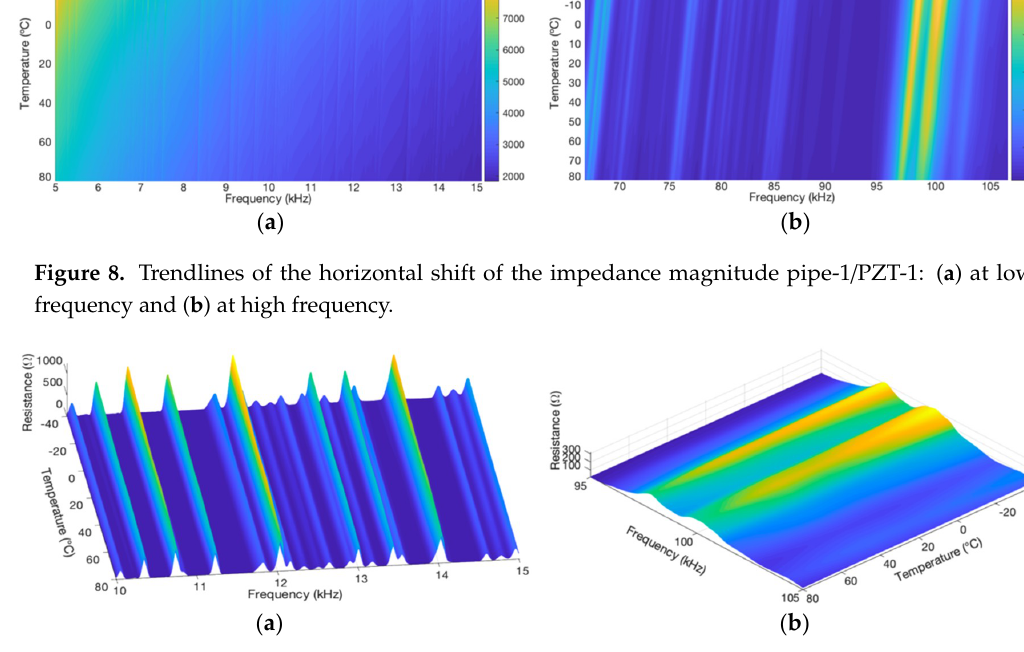
( b ) Figure 10. Damage metrics and the effect of temperature pipe-1/PZT-1: ( a ) RMSD and ( b ) CCDM. In Figure 10, it is observed that the real damage (red bar) presented a RMSD value lower than the values obtained by only changing the temperature, and a CCDM value very close to those obtained due to the temperature variation. In other words, in a real scenario, the temperature